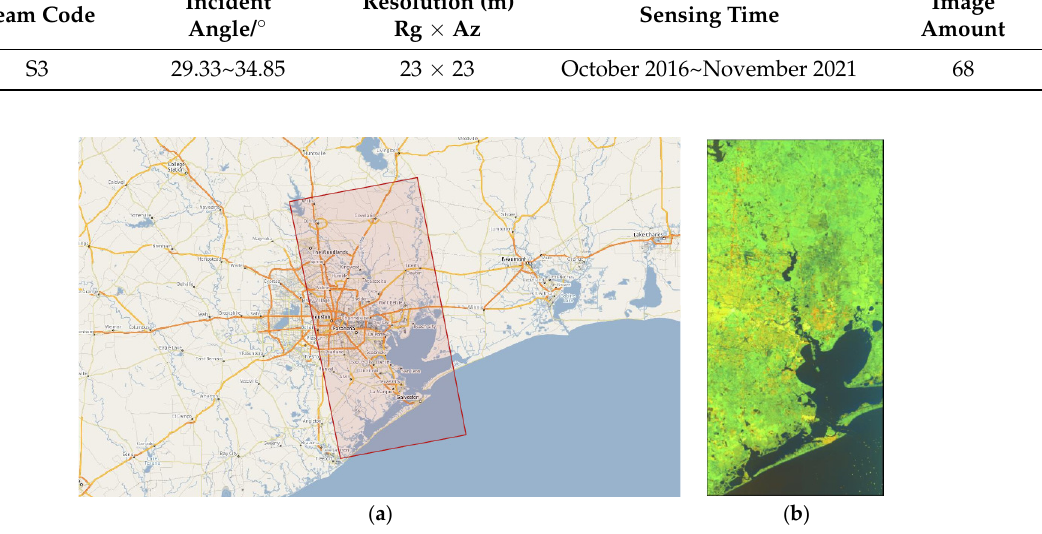
Figure 3. The imaging range of Houston scene of the experimental dataset and the corresponding quick-look image. ( a ) The imaging range of Houston scene data is shown in the red box. ( b ) The quick-look image from Sentinel-1 product. Table 1. Sentinel-1 dataset parameters.